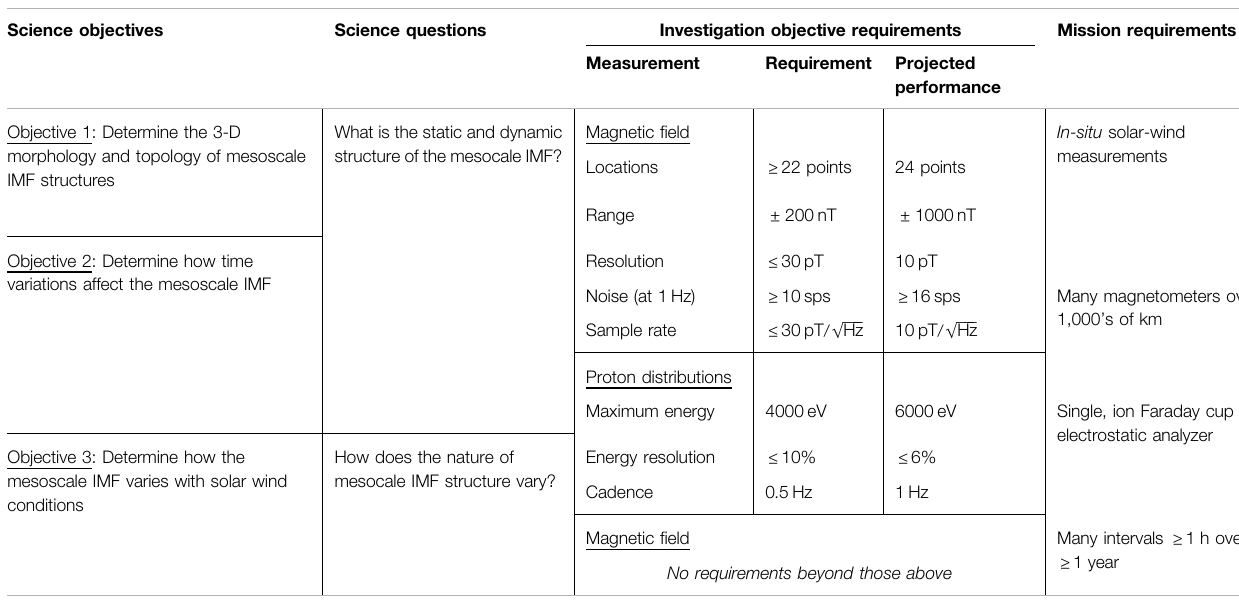
TABLE 2 | Science traceability matrix (STM) for